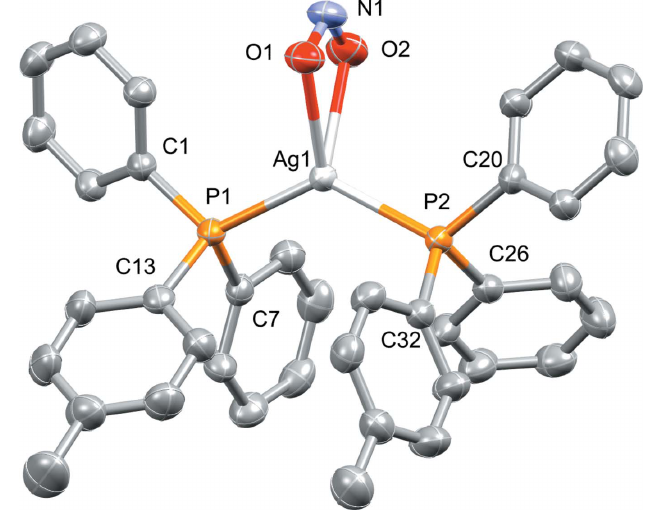
Figure 1 Perspective view of the molecular structure of the title compound showing displacement ellipsoids at the 50% probability level. Hydrogen atoms are omitted for